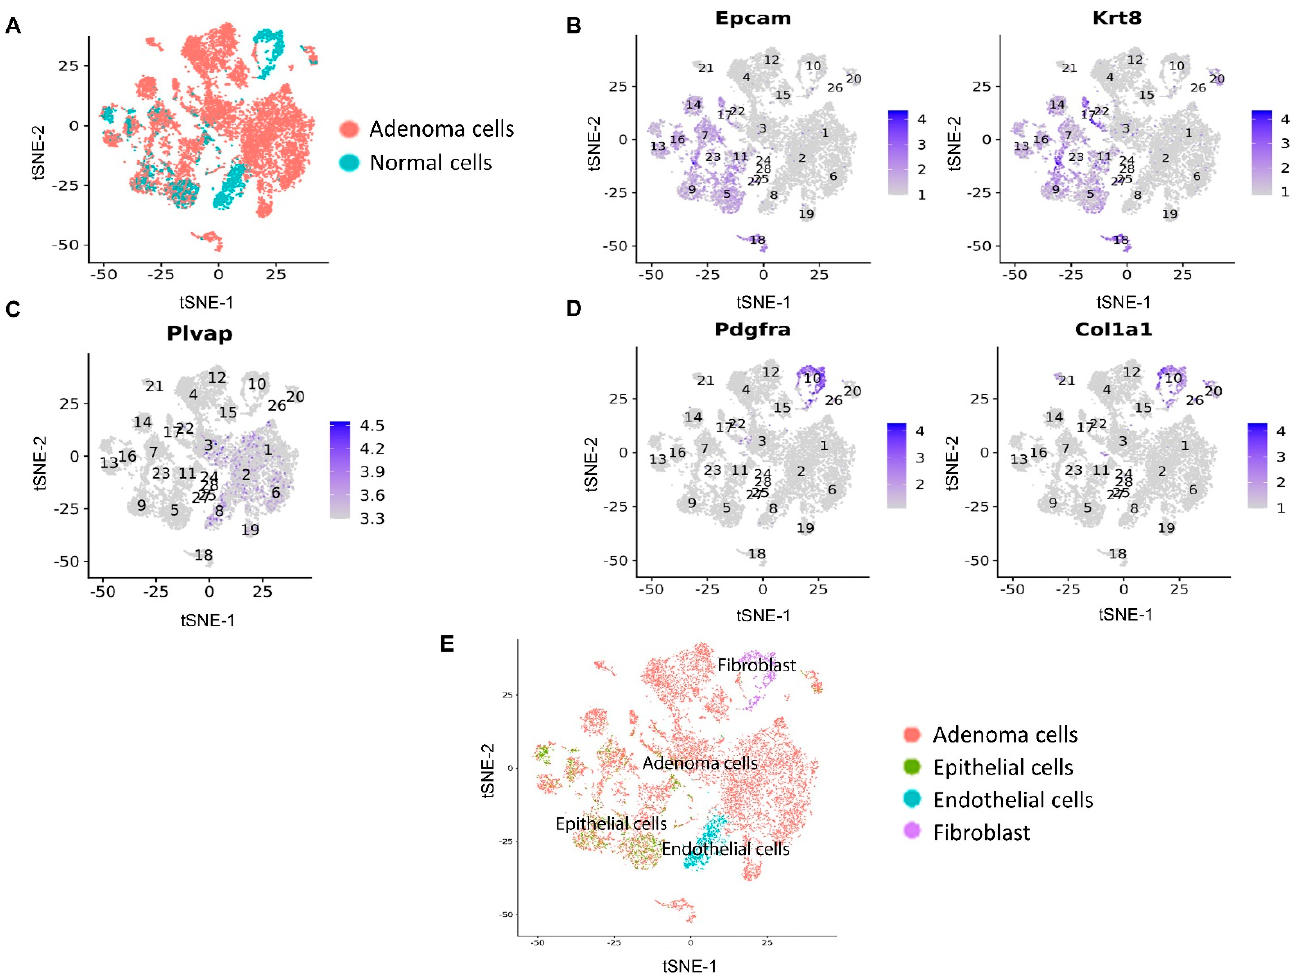
Figure 5. Clustering analysis based on scRNA-seq data of CD45- marker flow sorted mouse lung samples from control and Mito-LND treated mice. ( A ) Lung adenoma cells were identified using scCancer software. Marker gene expression for ( B ) epithelial cells, ( C ) endothelial cells, and ( D ) fibroblasts. ( E ) Annotation of CD45- cells into the four identified cell populations.